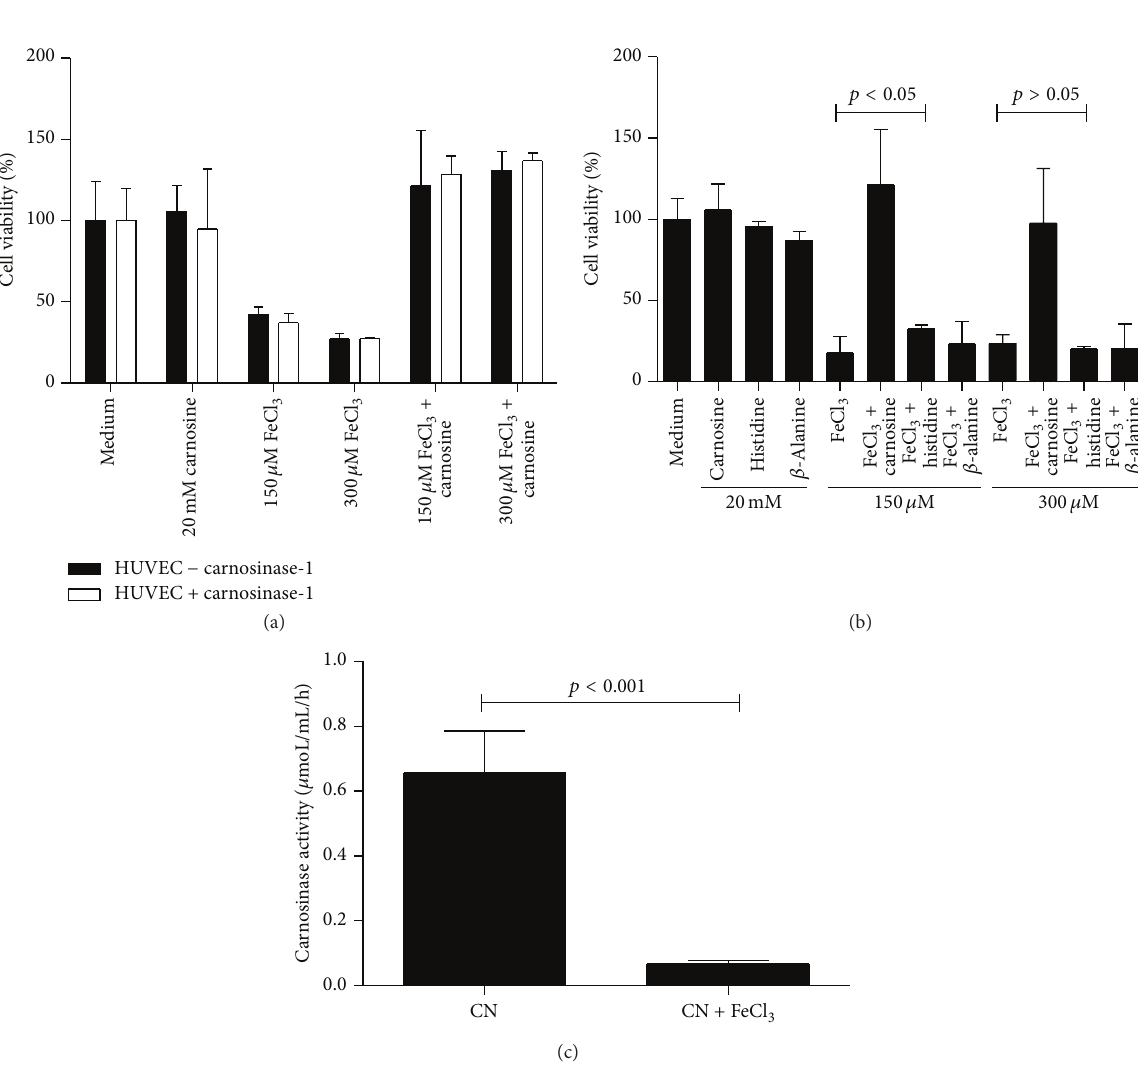
Figure 3: Ectopic expression of the human serum carnosinase-1 in HUVECs did not abrogate the protective effect of carnosine (a). The ability of the constitutive amino acids of carnosine, that is, 𝛽 -alanine and L-histidine, to protect HUVECs against iron mediated toxicity was tested (b). Although L-histidine was slightly protective when iron concentration was 150 𝜇 M, protection was clearly less compared to L-carnosine. No protection was afforded by 𝛽 -alanine. Recombinant carnosinase activity was attenuated by the presence of 300 𝜇 M FeCl 3 (c). CN: carnosine.